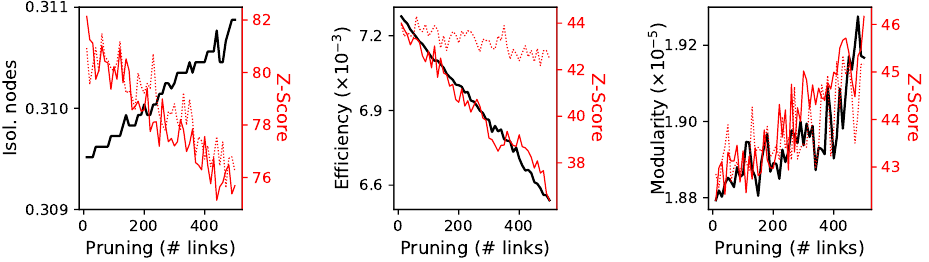
Figure 8. Properties of the interaction networks subject to a pruning process, as a function of the number of deleted links. See Figure A11 for full results, and the main text for a description of the pruning strategy. Solid black (left Y axes) and red lines (right Y axes), respectively, correspond to the raw values of the metrics and the associated Z-Scores. Dotted red lines (right Y axes) report the Z-Scores of the metrics in the case of a random pruning process—see the full results in Figure